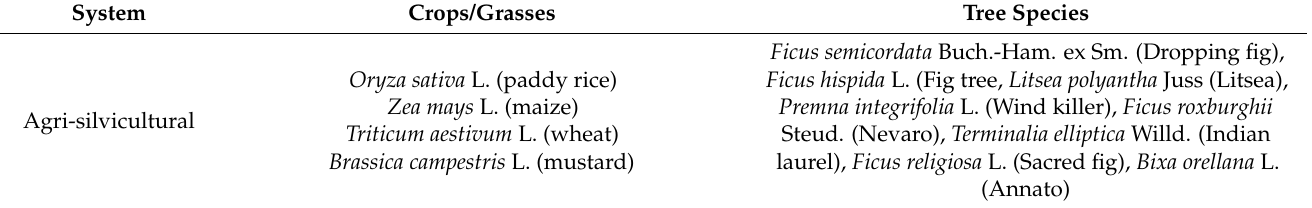
Table 1. Major species used in different AF